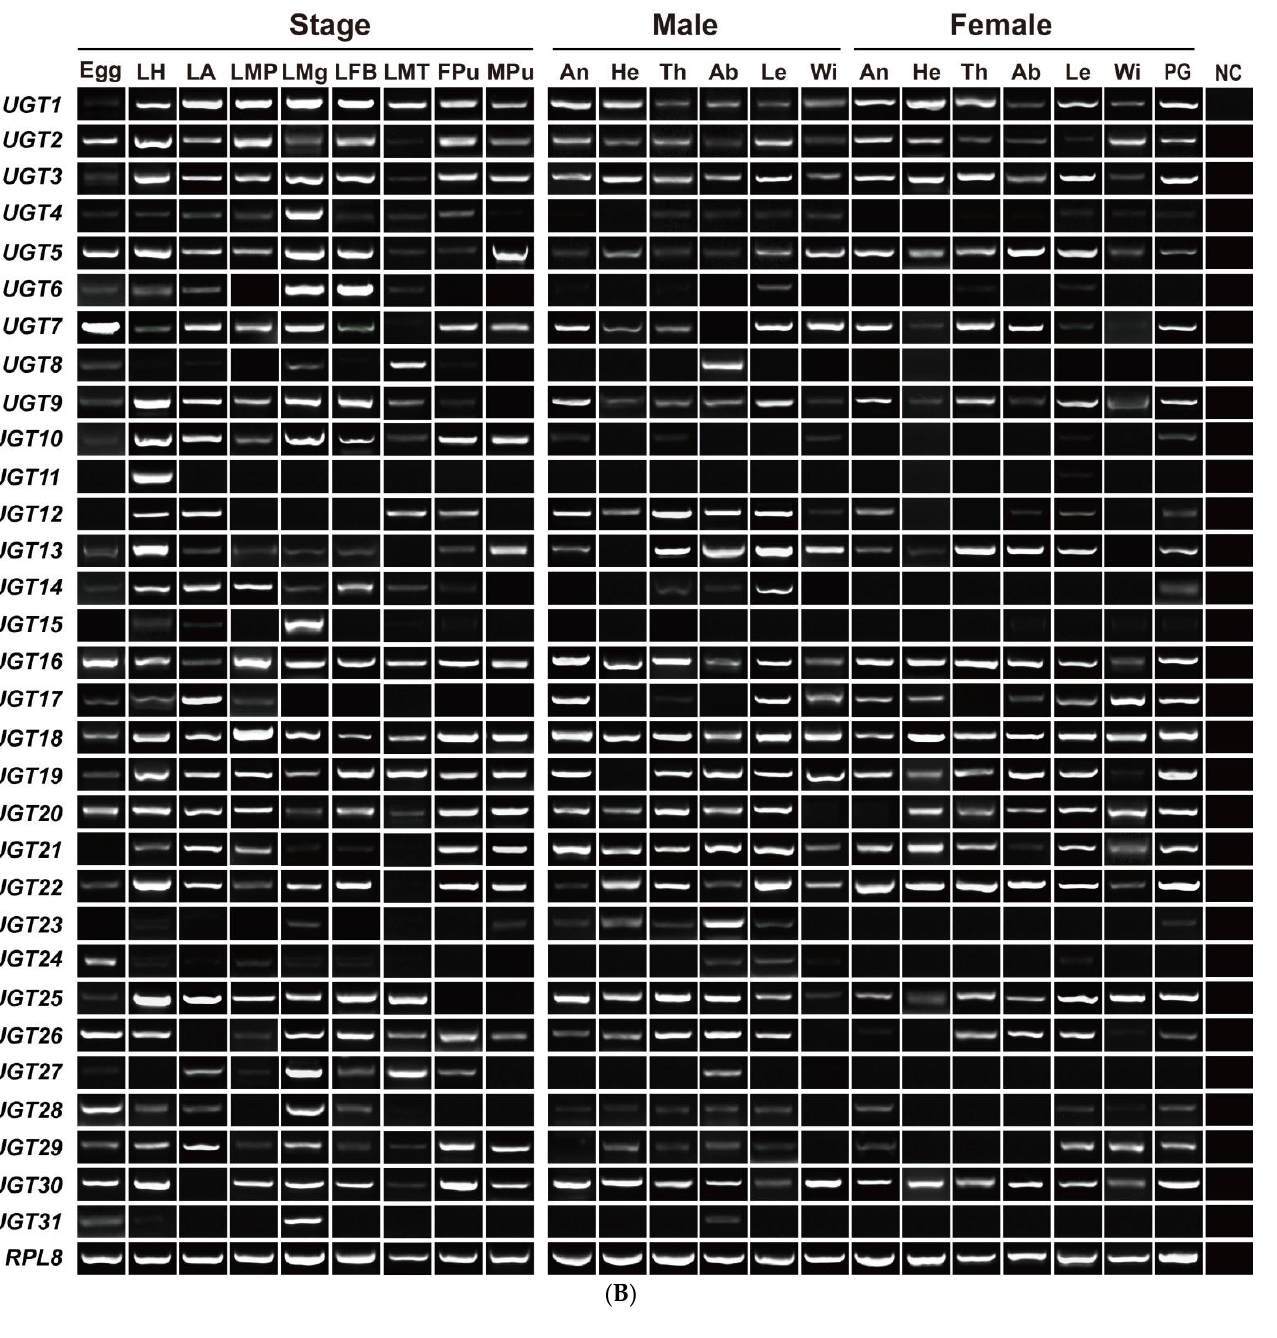
Figure 3. Expression profile of 31 full-length UGT genes in different tissues of A. yunnanensis . ( A ) Expression of UGT genes as determined by FPKM values. ( B ) Expression of UGT genes as determined by RT – PCR. LA, larval antennae; LH, larval heads without antennae; LMP, larval maxillary palps; LMg, larval midguts; LFB, larval fat bodies; LMT, larval Malpighian tubules; FPu, female pupae; Mpu, male pupae; An, antennae; He, heads without antennae; Th, thoraxes; Ab, abdomens; Le, legs; Wi, wings; and PG, pheromone glands.